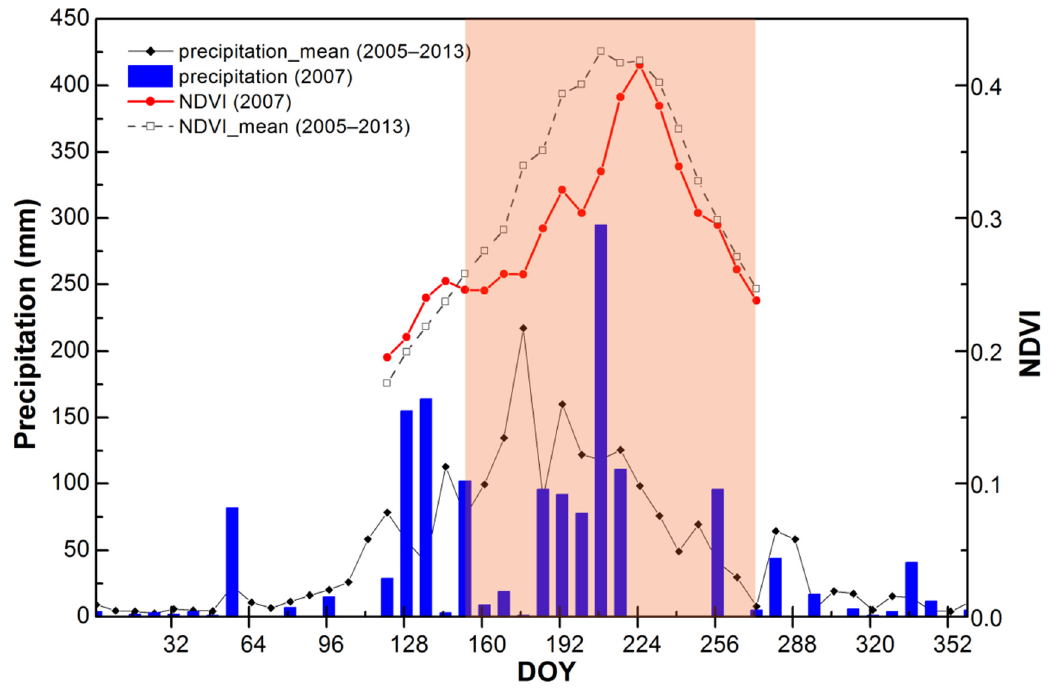
Figure 8. Time series of precipitation and predicted synthetic NDVI (8-d intervals) for Xilinhot in 2007 (precipitation data at site Xilinhot were obtained from the China meteorological data sharing service system).